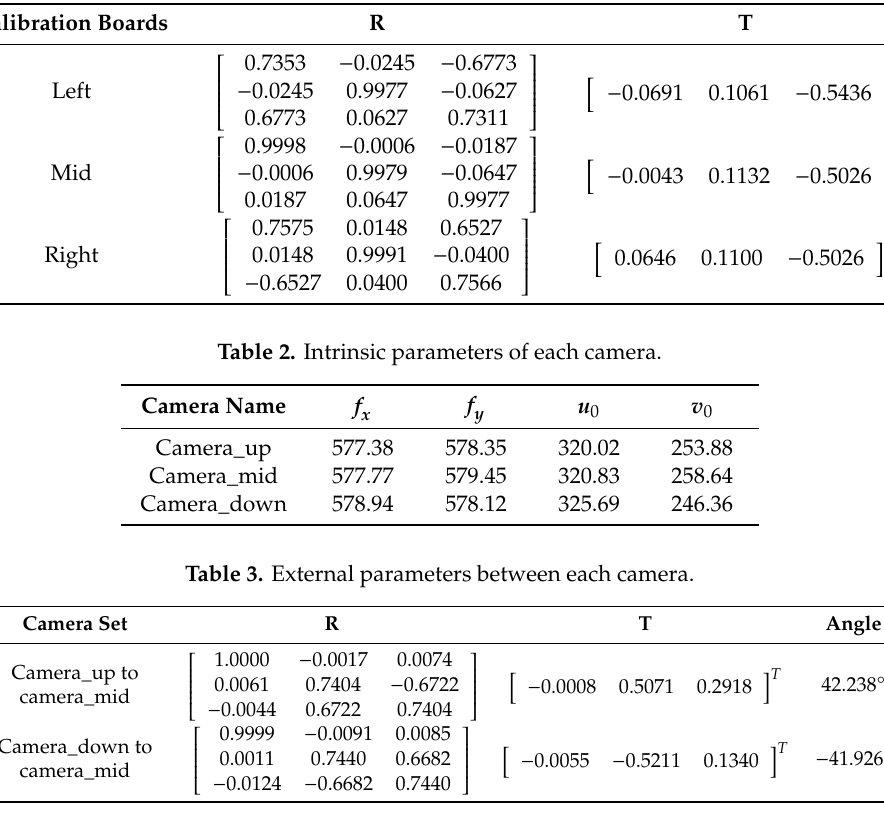
Table 1. External parameters of each calibration board.